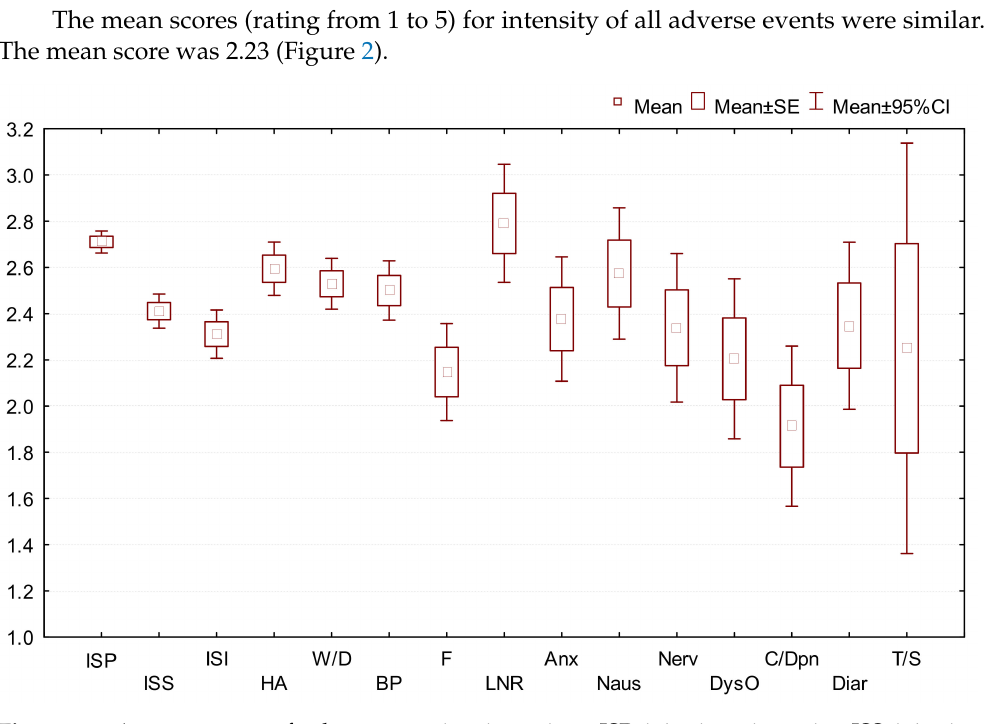
Figure 2. Average score of adverse reaction intensity. ISP–injection site pain; ISS–injection site swelling; ISI–injection site itching; HA–headache; W/D–weakness, drowsiness;